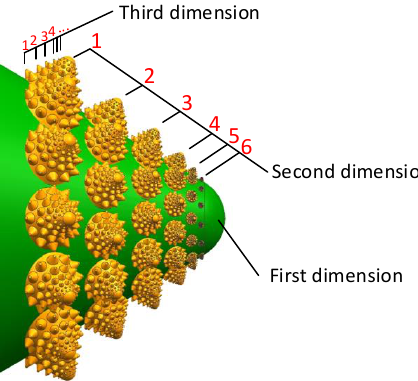
Figure 5. Bionic fractal structure at the front of the valve core.